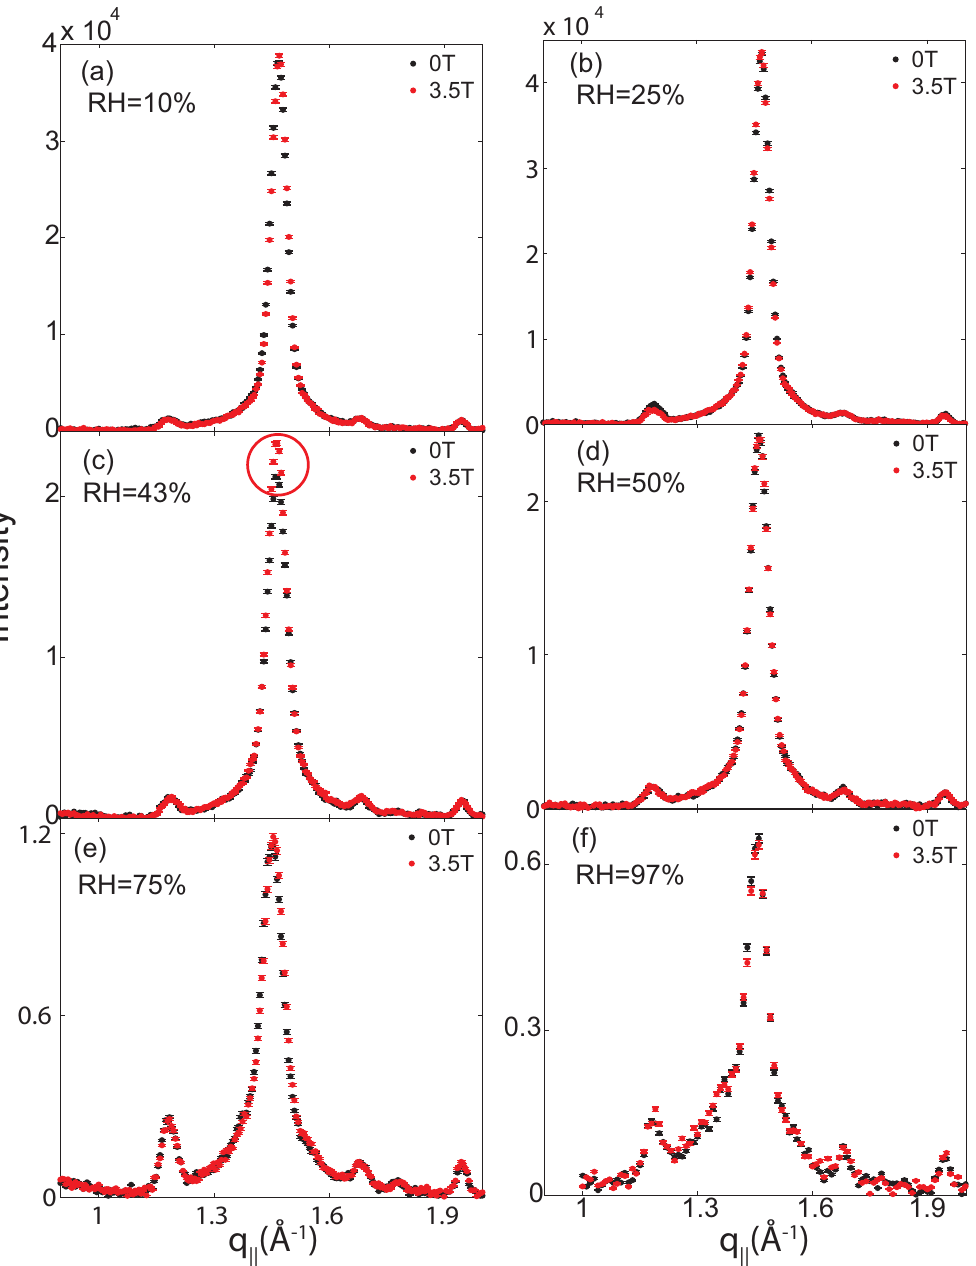
Figure 4. In-plane diffraction patterns for all membranes prepared for this study. Curves measured at 0 T and at 3.5 T are overlaid for an easy comparison. A difference with and without an applied external magnetic field was observed for 43% relative humidity, only. All other curves agree within the resolution of this